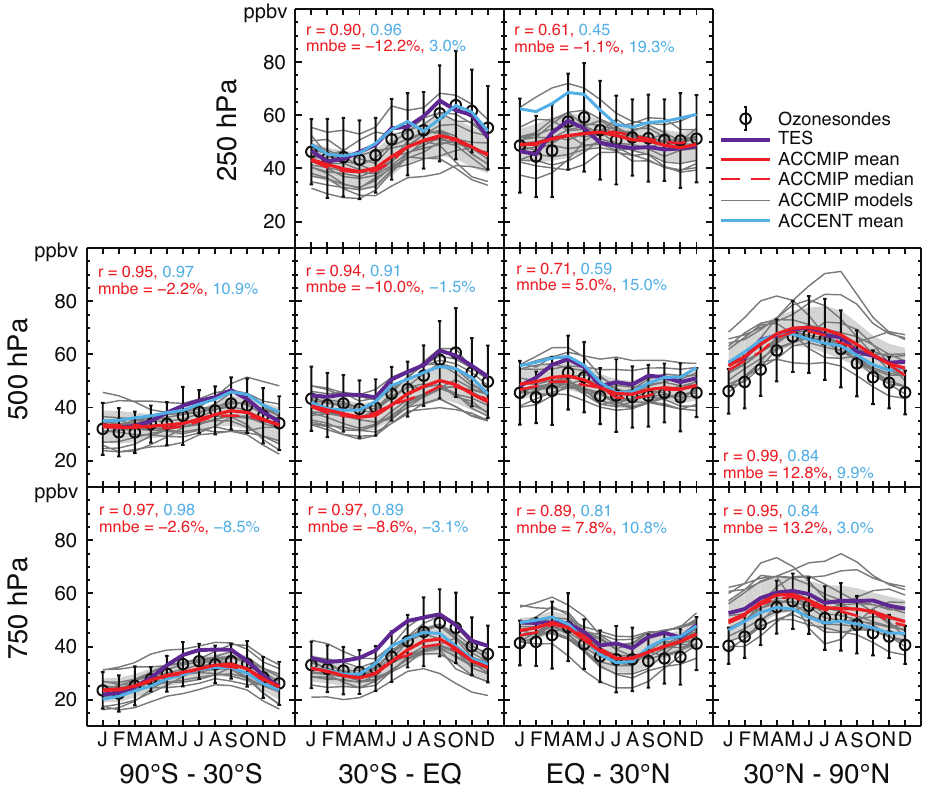
Fig. 4. Comparison of the annual cycle of ozone, between ozonesonde observations (black circles) and the ACCMIP ensemble mean (solid red line), ACCMIP ensemble median (dashed red line) and the ACCENT ensemble mean (blue line) (Stevenson et al., 2006). Ozone concen- trations from TES (purple line) are also shown. ACCMIP model data is from the 2000 time slice mean of the Historical experiment. Model and observational data were grouped into four latitude bands (90 ◦ S to 30 ◦ S, 30 ◦ S to 0 ◦ , 0 ◦ to 30 ◦ N and 30 ◦ N to 90 ◦ N) and sampled at three altitudes (700hPa, 500hPa and 250 hPa), with the models sampled at the ozonesonde locations before averaging together. The individ- ual ACCMIP models are represented by the thin grey lines, with the grey shaded area indicating ± 1 standard deviation about the ACCMIP ensemble mean, showing the model spread. Error bars on the observations indicate the average interannual standard deviation for each group of stations. The correlation ( r ) and mean normalised bias error (mnbe) for the ACCMIP (red) and ACCENT (blue) ensemble means versus the observations are also indicated in each panel. This figure is an update of Fig. 2 of Stevenson et al.